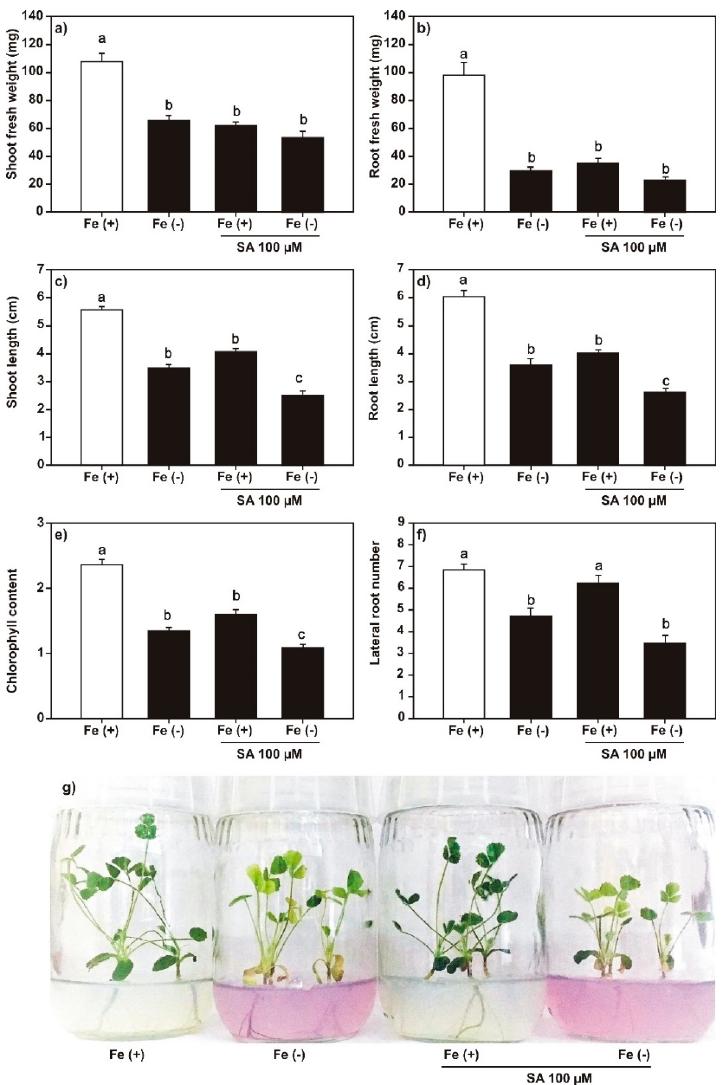
Figure 2. Effect of salicylic acid (SA) on Medicago truncatula growth. The M. truncatula plants were cultured in MS medium with SA (100 μ M) under both iron sufficiency (control) and iron deficiency for 14 days. ( a ) Shoot fresh weight; ( b ) root fresh weight; ( c ) shoot length; ( d ) root length; ( e )